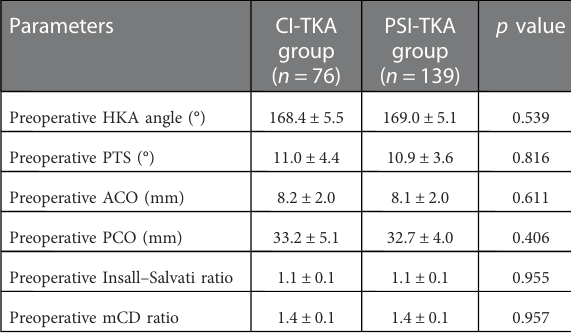
TABLE 2 Preoperative radiographic